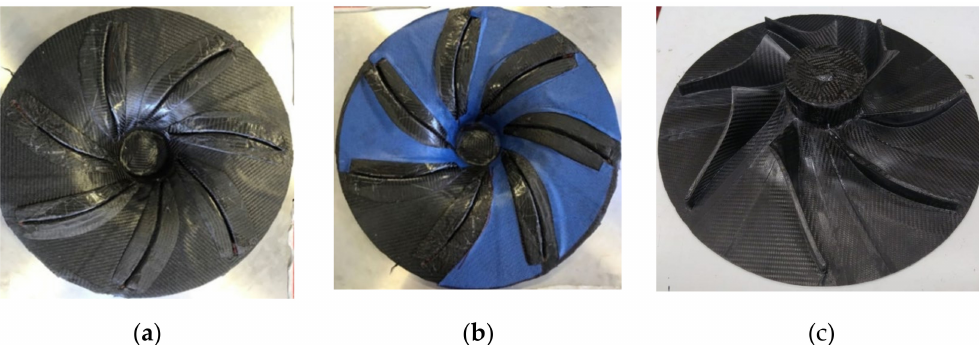
Figure 14. Representations of the composite impeller first manufacturing step: ( a ) positioning of the 7 composite blades on the base composite layers; ( b ) composite layers applied to uniform the thickness; ( c ) composite impeller after first manufacturing process.